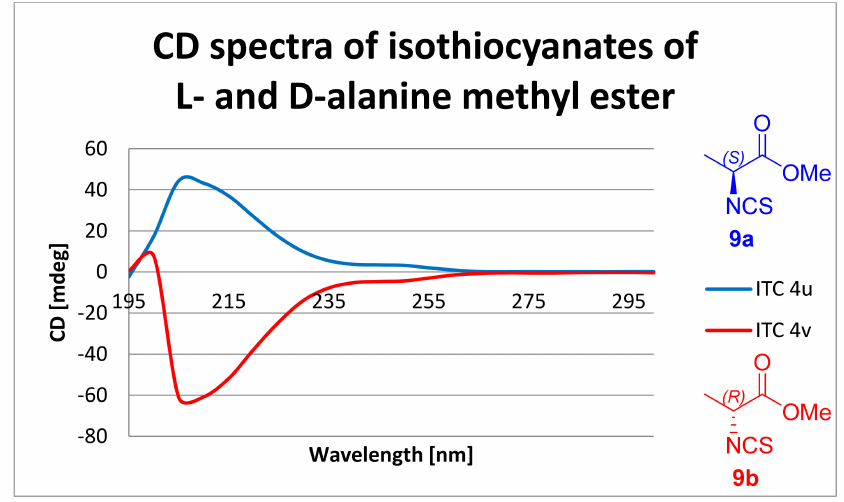
Figure 7. CD spectra of ITCs 9a and 9b .